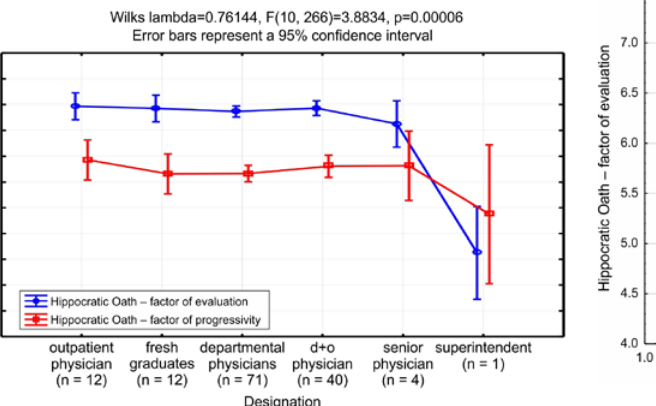
Figure 5: Semantic space of the Hippocratic Oath according to